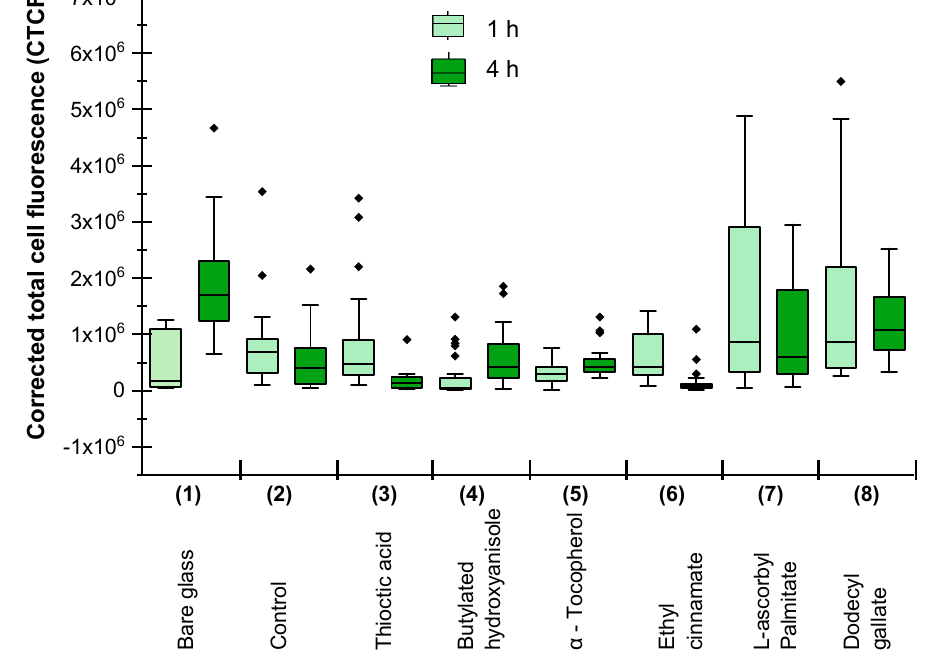
Figure 3. Corrected total cell fluorescence (CTCF) on bare glass (Sample 1); control, glass with siloxane composite coating without antioxidants (Sample 2) or containing different antioxidants: Thioctic acid (Sample 3); Butylated hydroxyanisole (Sample 4); α -Tocopherol (Sample 5); Ehthyle cinnamate (Sample 6); L-ascorbile palmitate (Sample 7); Dodecyl gallate (Sample 8).